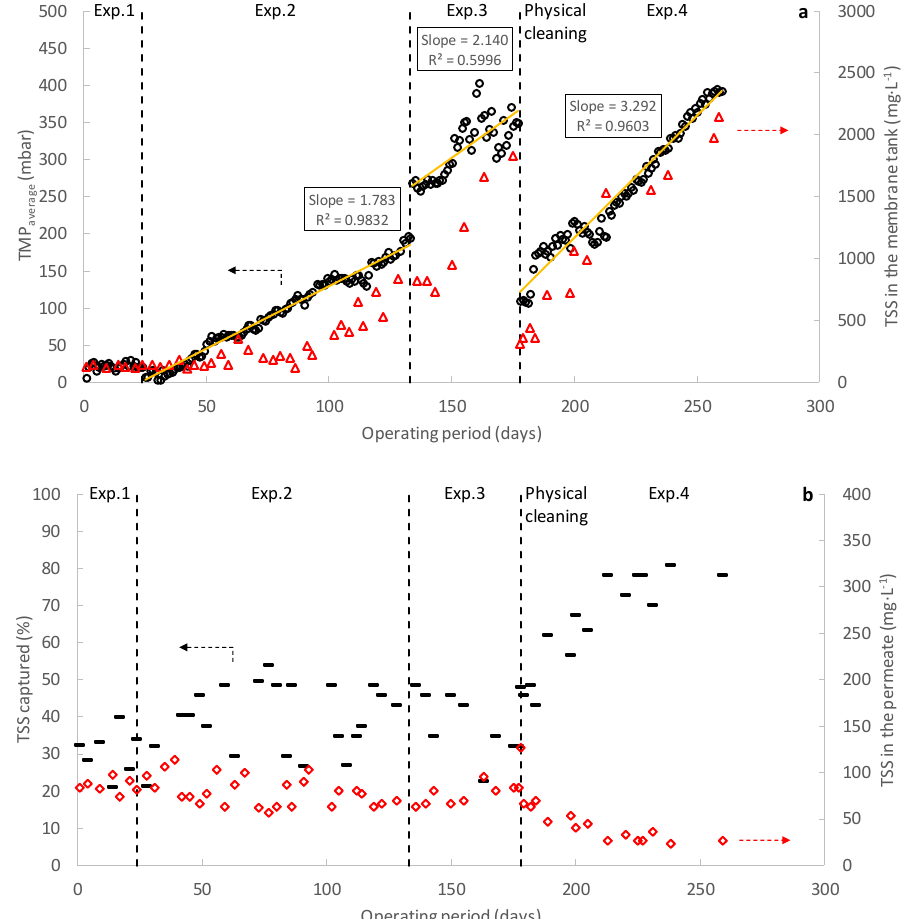
Figure 2. Pilot-plant performance. Evolution of ( a ) transmembrane pressure (TMP) and total sus- pended solids (TSS) concentration, and ( b ) TSS capture efficiency and permeate TSS concentration. TMP average ; TSS in the membrane tank; TSS capure efficiency; TSS in the permeate. The continuous lines represent linear fits.